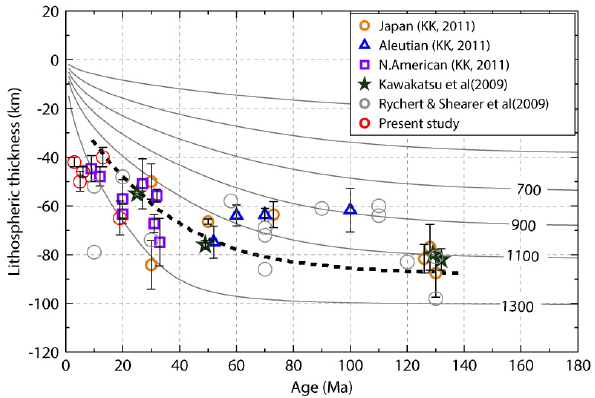
Figure 6. Observed lithospheric thickness values plotted against their age. Different color symbols denote data from different sources and red open circles denote the observations from the present study. Isotherms (gray contour lines with a 200 ◦ C interval) and the estimated top of partial melting region (the black, dashed contour line) are taken from Kawakatsu et al. (2009). KK: Kumar and Kawakatsu et al.